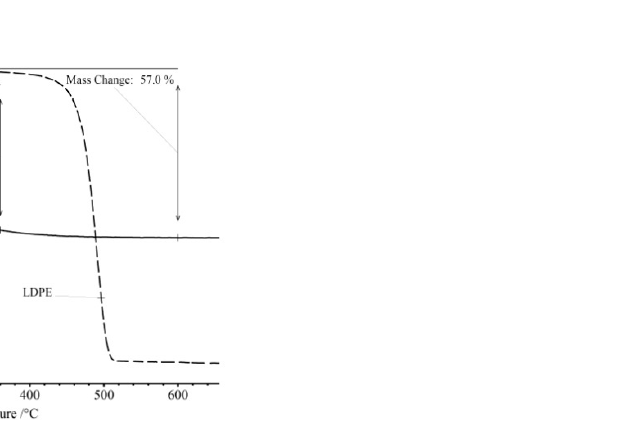
Figure 1. The results of the thermogravimetric analysis in an inert atmosphere for the pyrolysis product LDPE (curve 1) and the initial LDPE.